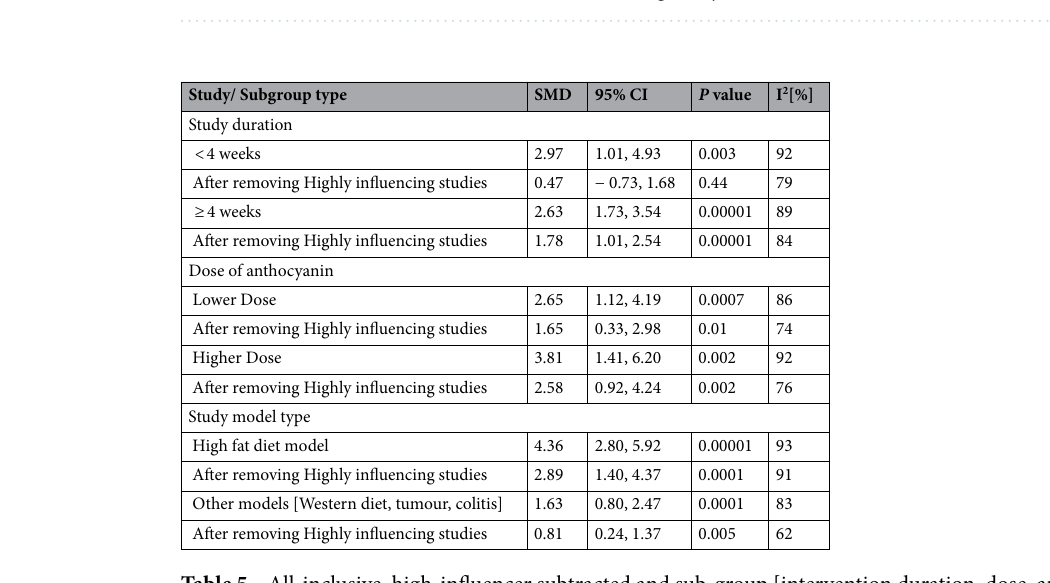
Table 5. All-inclusive, high-influencer subtracted and sub-group [intervention duration, dose, and animal model type] analysis to understand the effects of anthocyanins on the acetic acid. Pooled effect sizes and 95% CI were determined using Random effects model. SMD Standardised mean difference, I 2 Heterogeneity.